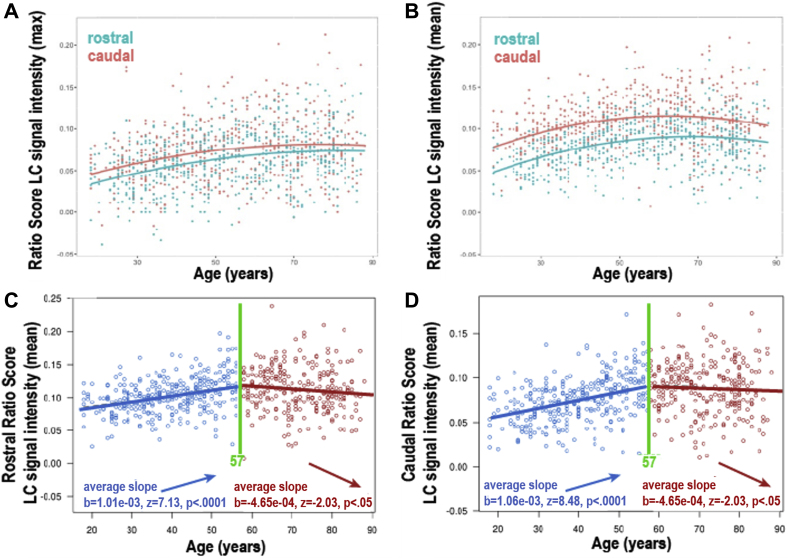
Graphs showing regional age-related differences in LC CR, plotting maximum (A) or mean (B, C, D) LC CR for rostral/caudal regions of LC and age in years. Solid red and blue circles (A and B) represent individual data points for rostral and caudal LC CR values, respectively. Unfilled circles (C and D) represent individual data points (n = 605). Age-related differences were observed for maximum (A) and mean (B) LC CR within rostral and caudal regions of LC, and the rostral region showed significantly higher LC CR values than the caudal region. Quadratic models were a better fit for the data compared with a linear model according to the AIC. A subsequent two-lines test revealed an inverted U-shaped relationship (with breakpoints shown in green) between mean LC CR and age in the rostral region but not in the caudal region, as both the upward (p < 0.001) and downward (p = 0.0426) slopes for the former reached statistical significance. Abbreviations: LC, locus coeruleus; CR, contrast ratio; AIC, Akaike information criterion. (For interpretation of the references to color in this figure legend, the reader is referred to the Web version of this article.)